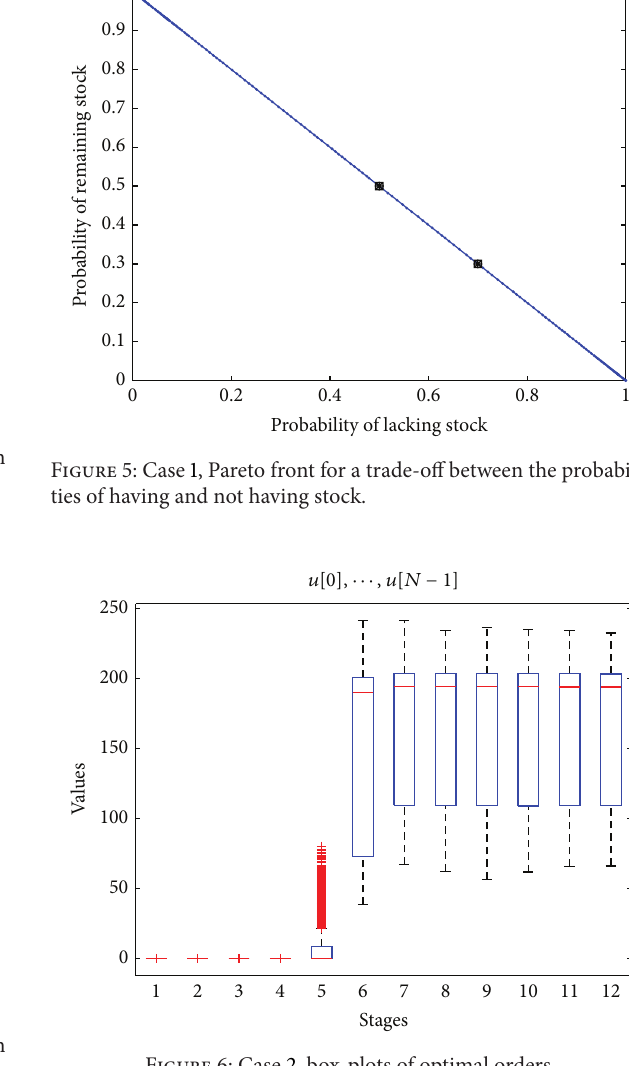
Figure 6: Case 2, box-plots of optimal